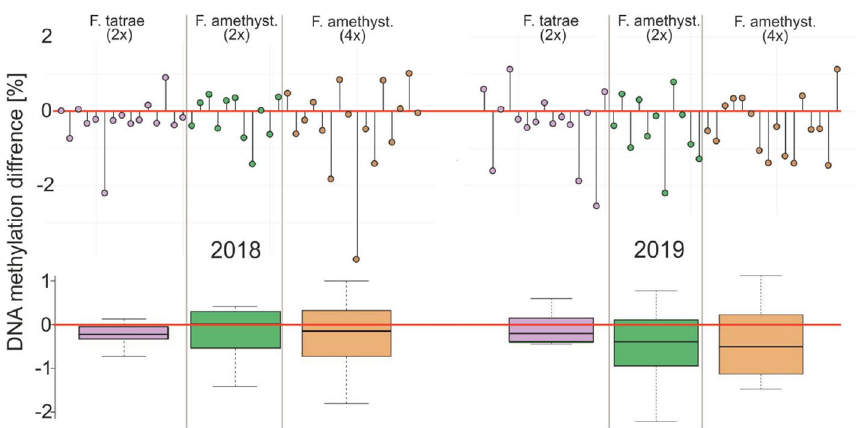
Figure 2. Variation in the global DNA methylation level between stress and control conditions in the common garden experiment in a given year, for studied specimens (point plots) and for species and cytotypes (boxplots: horizontal line—median, boxes—25–75th percentile,